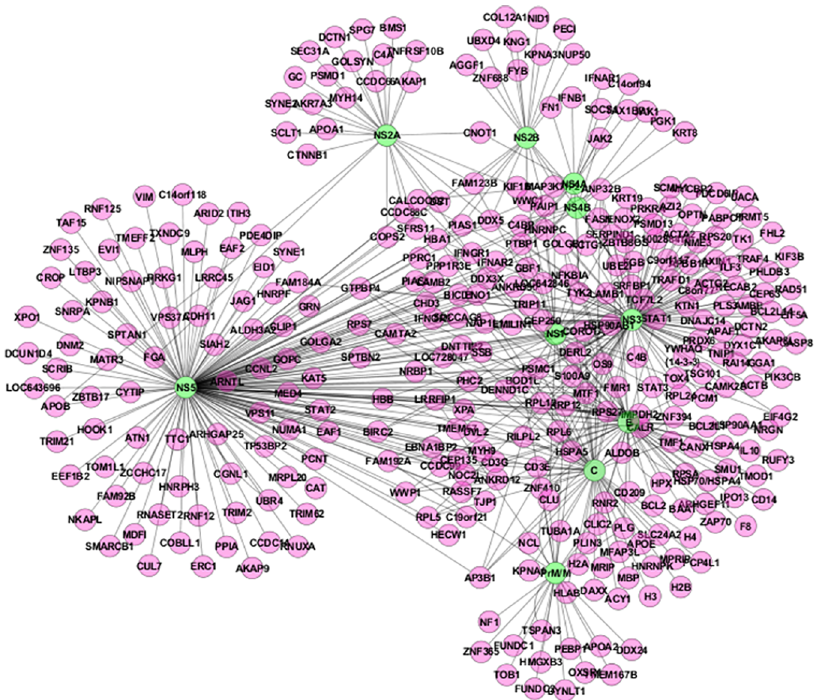
Fig 9. Dengue–human PPI network. A completeset of dengue–human protein interactions identifiedin this study is shown. Green ovals indicatedengueproteins, pink ovals indicatehumanproteins, and black lines indicatedengue–human protein interactions. PPI, protein–protein interactions.